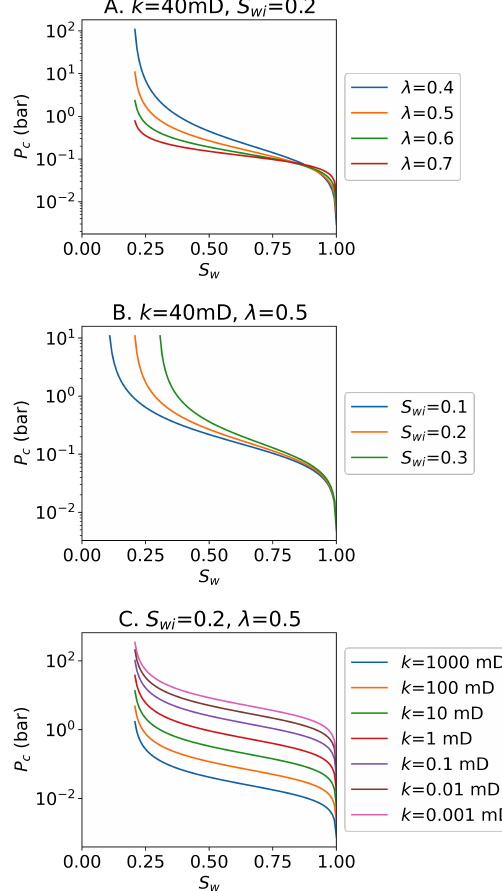
Figure A2. ( A ) Capillary pressure curves for different λ values with fixed permeability and S wi